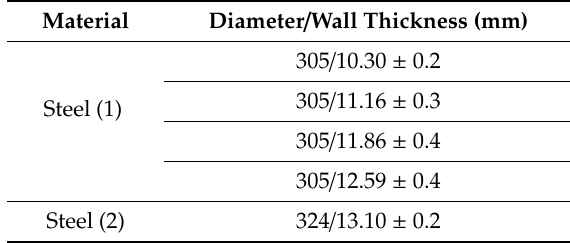
Table 2. Pipes used for the study: material pipe diameters and wall